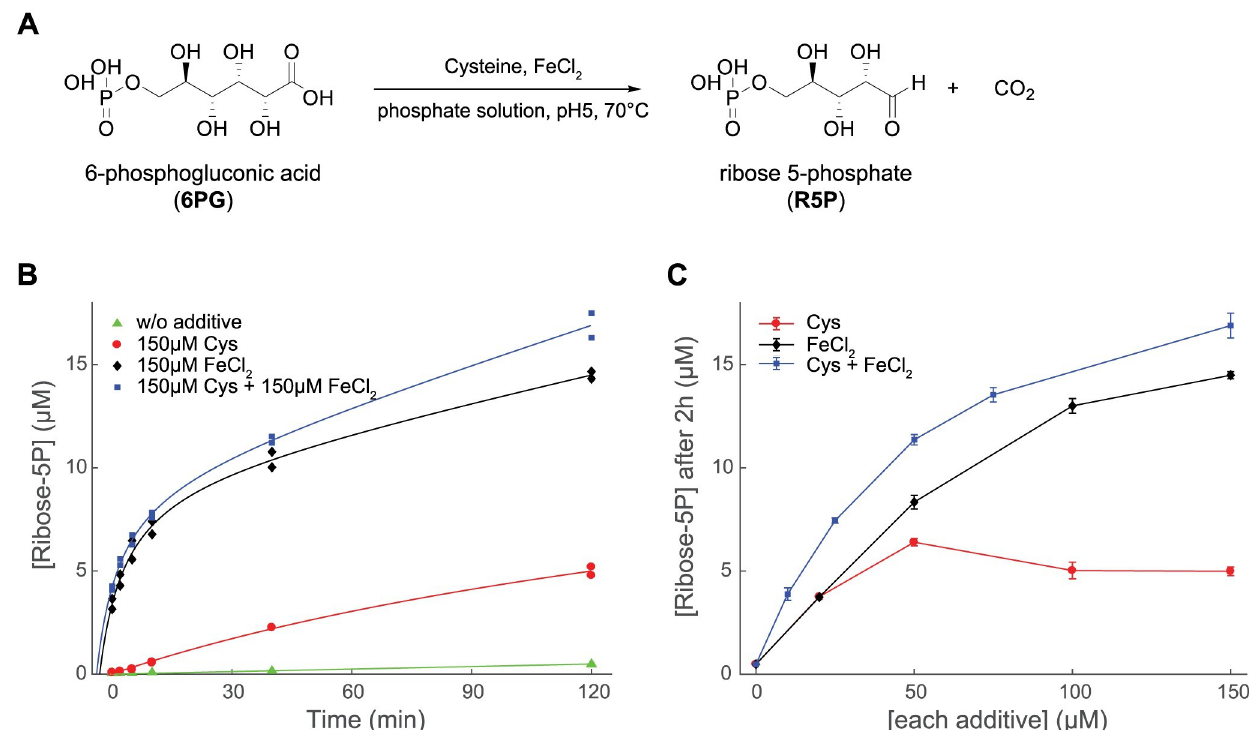
Fig 2. Nonenzymatic formation of R5P from 6-phosphogluconate. (A) The nonenzymatic reaction of conversion of 6-phosphogluconate to R5P. (B, C) The formation of R5P from 800 μ M 6PG in 50 mM phosphate solution at pH 5 was monitored at 70˚C for (B) different time points ( N = 2) (see S1 Data) and (C) different concentrations of cysteine, Fe(II), or both species (combined in a molar ratio 1:1). Data shown as mean ± SD ( N � 2 per condition) (see S1 Data). 6 AU : AbbreviationlistshavebeencompiledforthoseusedforFigs 2 (cid:0) 4 : Pleaseverifythatallentriesarecorrect : PG, 6-phosphogluconic acid; R5P, ribose-5-phosphate.